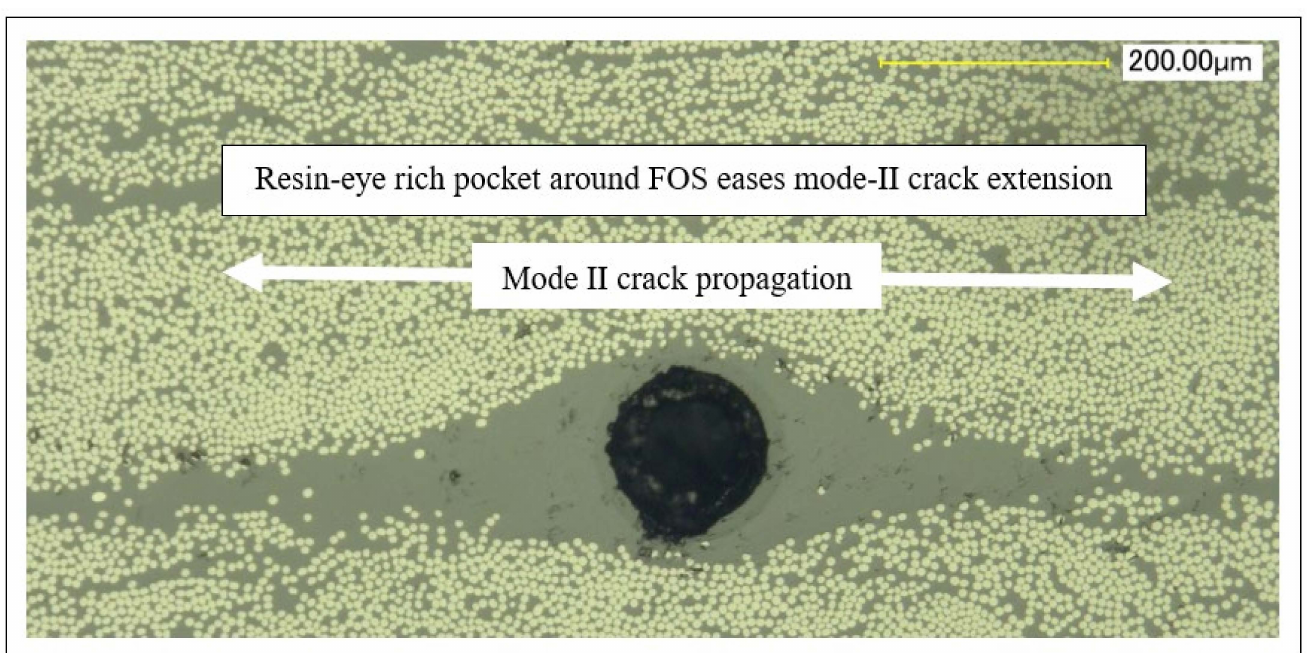
Figure 1. Resin-eye rich concentrations around FOS. The bigger is FO diameter, the more facilitated is mode-II delamina-tion crack initiation and